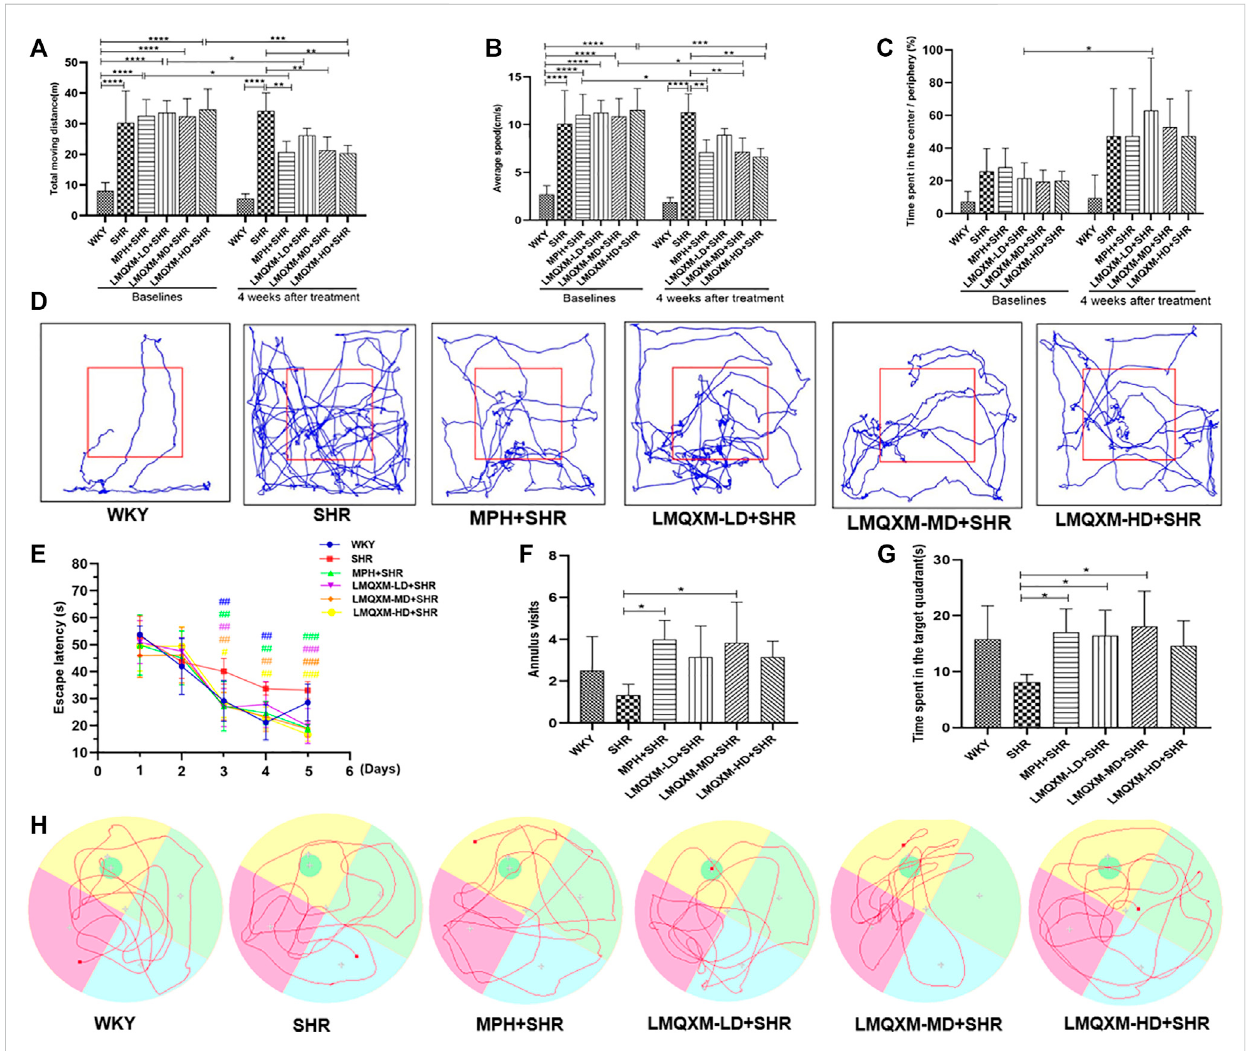
FIGURE 6 Behavioral performance of rats in each group in OFT and MWM tests (A) Moving distance in OFT (B) Average speed in OFT (C) . Time spent in the center/Periphery in OFT (D) Representative trajectories of each group of rats in OFT (E) Escape latency in MWM test (F) Number of annulus visits in